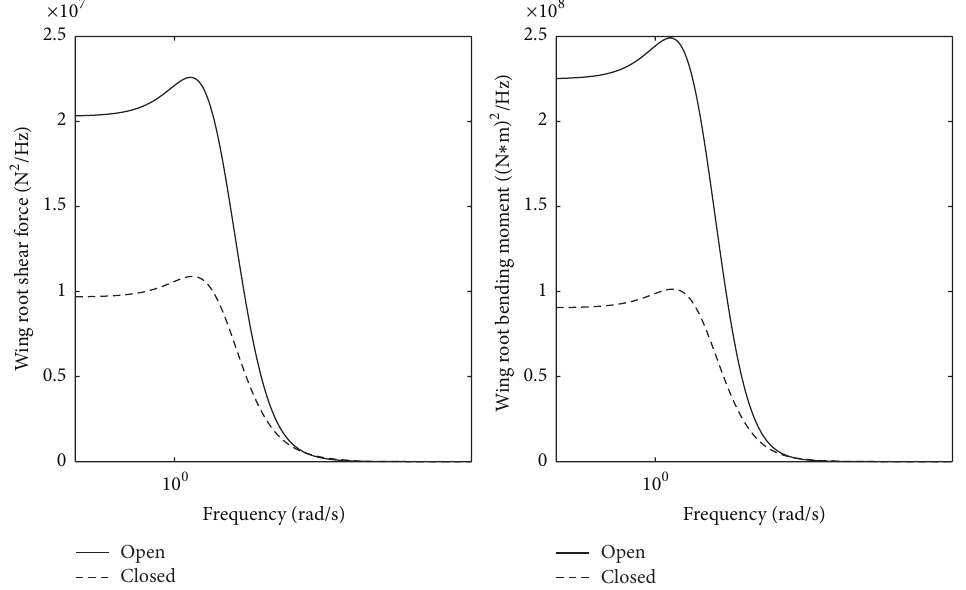
Figure 7: Open- and closed-loop PSD functions from wind gust to wing root load at Ma = 0.7 and 𝑞 = 40 kPa.